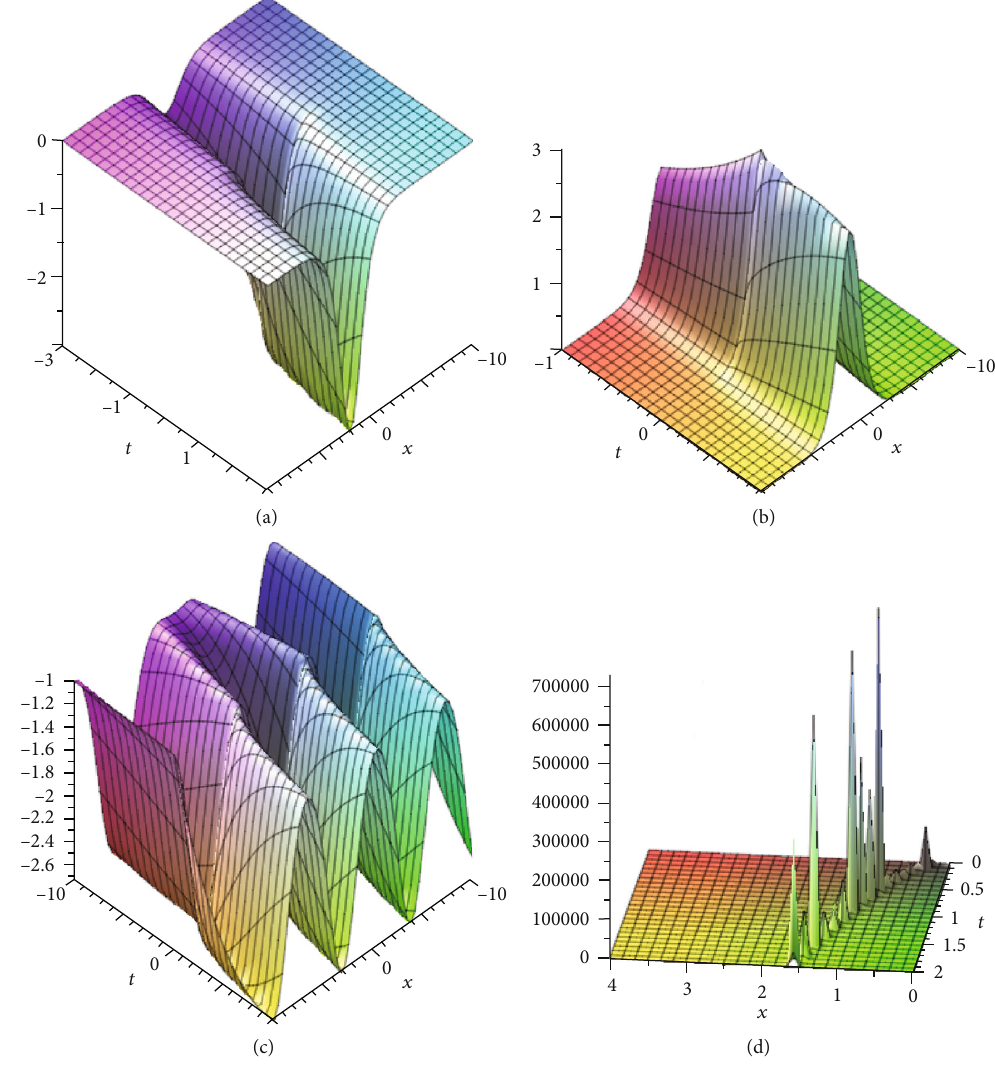
Figure 4: The pro fi le of the solutions of Equation (1): (a) A = 1, b = 2, k = 1, n = 1, α = 0 : 5, and y = z = 0 ;.(b) A = − 1, B = 2, k = 1, n = 1, α = 0 : 5, and y = z = 0 ; (c) A = 1/2, B = 1, k = 1, n = 1, h = − ð 1/3 Þ , α = 0 : 5, and y = z = 0 ; (d) A = 1, B = 0, k = 1, n = 1, α = 0 : 5, and y = z = 0